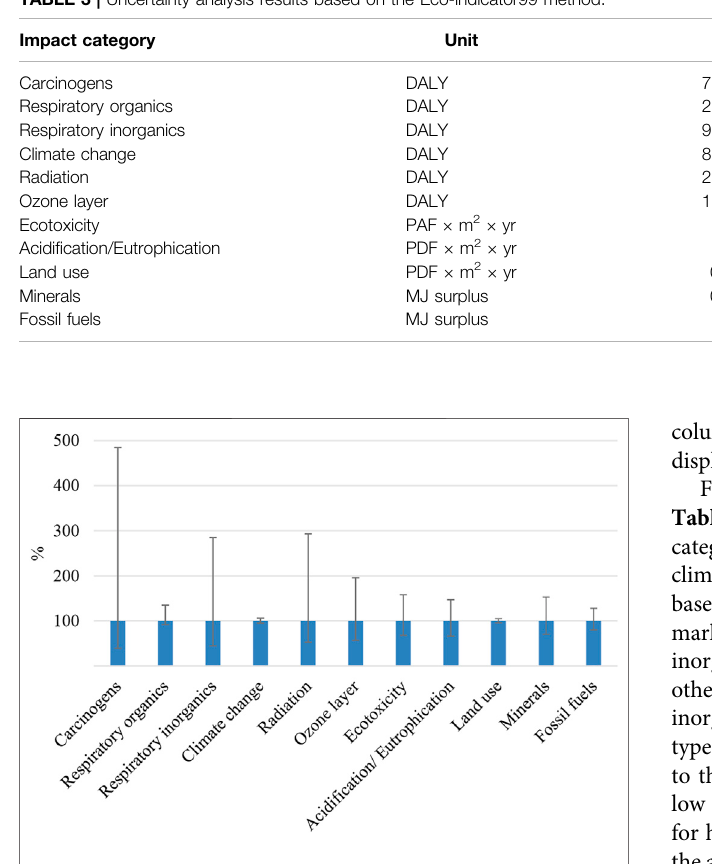
FIGURE 8 | Uncertainty analysis results using the Eco-indicator99 method.